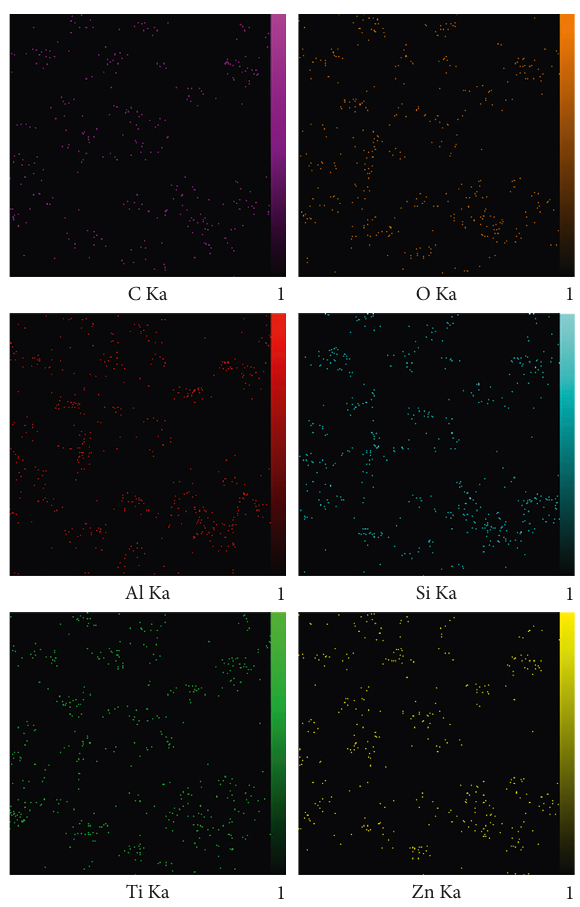
Figure 5: TEM image of ZnO/TiO